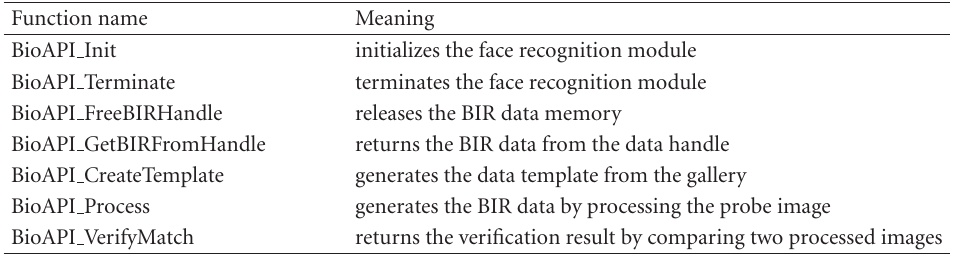
Table 3: Selected BioAPI for face recognition module.